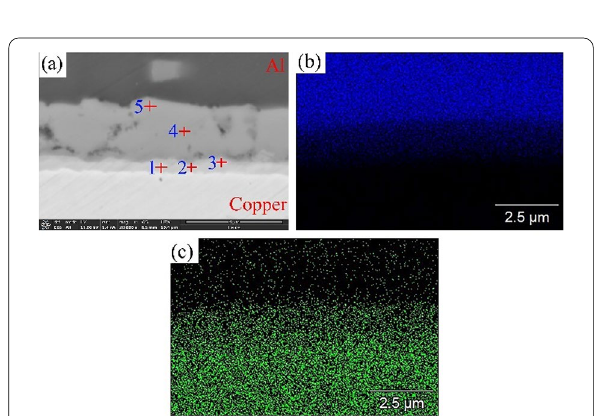
Figure 3 Cross sectional view of the weld manufactured using a 1.8 mm penetration depth